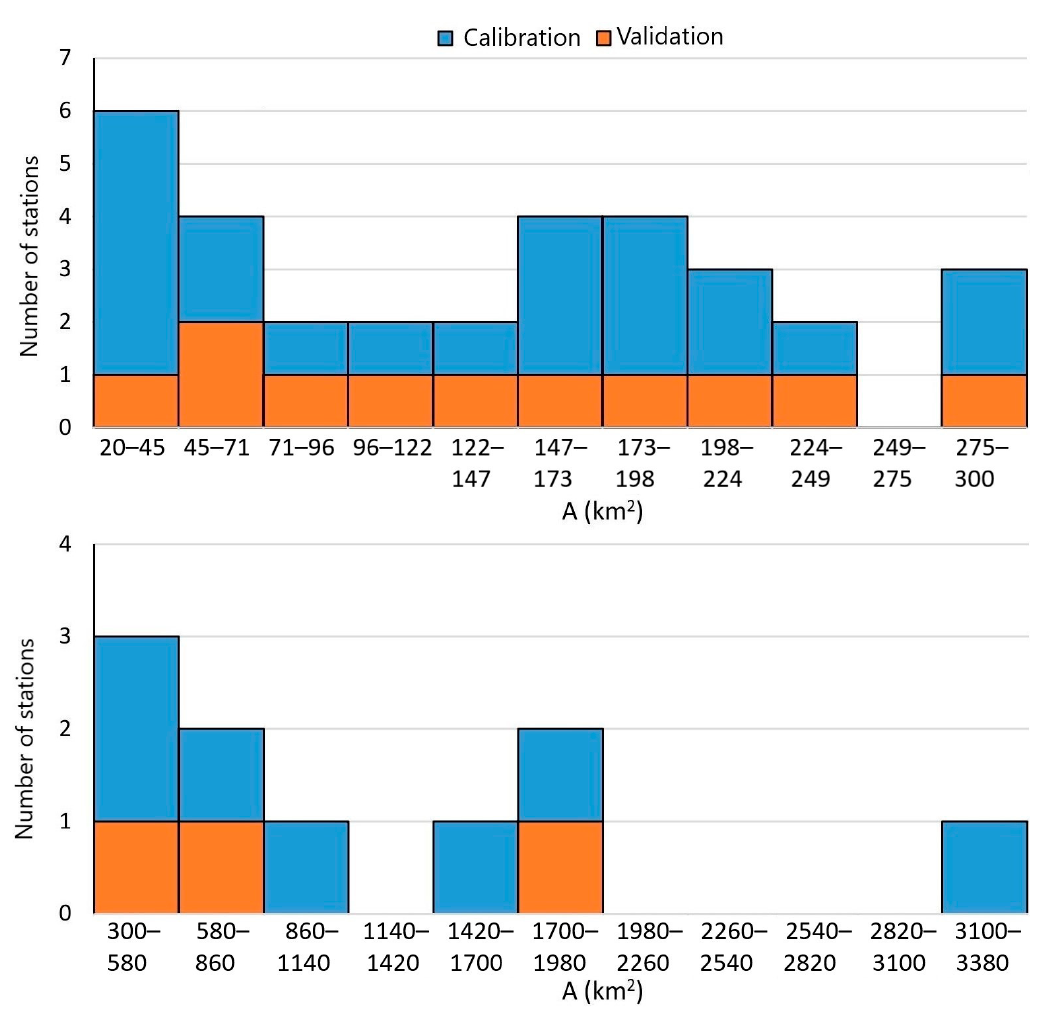
Figure 3. Selection of the calibration and validation streamflow gauging stations based on their drainage area, A < 300 km 2 (upper panel) and A > 300 km 2 (lower panel).